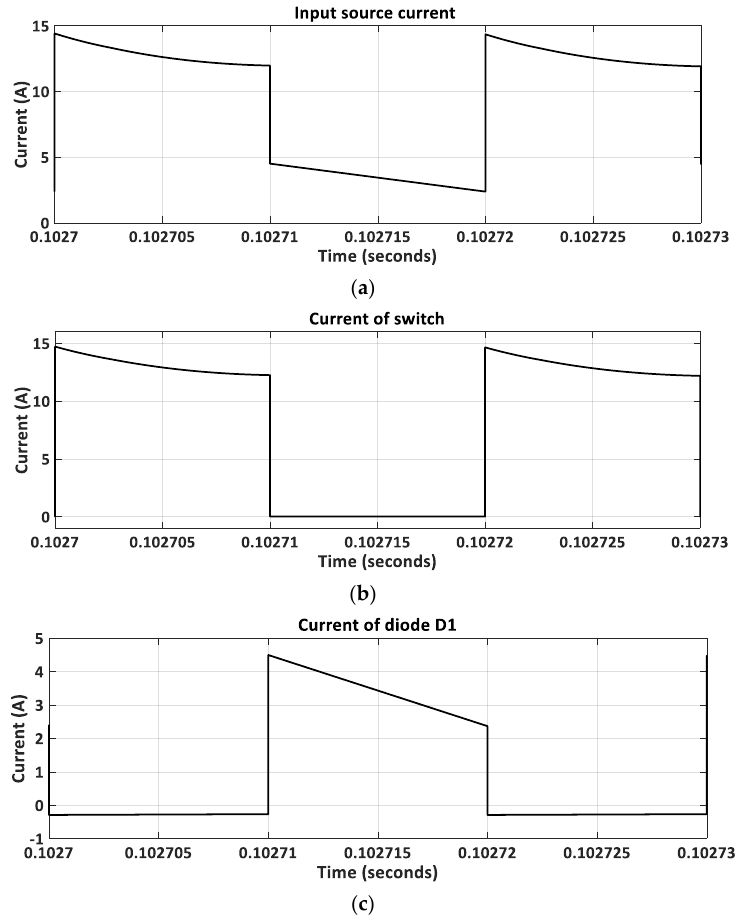
Figure 15. ( a ) Input source current and the current of the ( b ) switch and ( c ) diode D1 in the proposed boost converter. boost L f